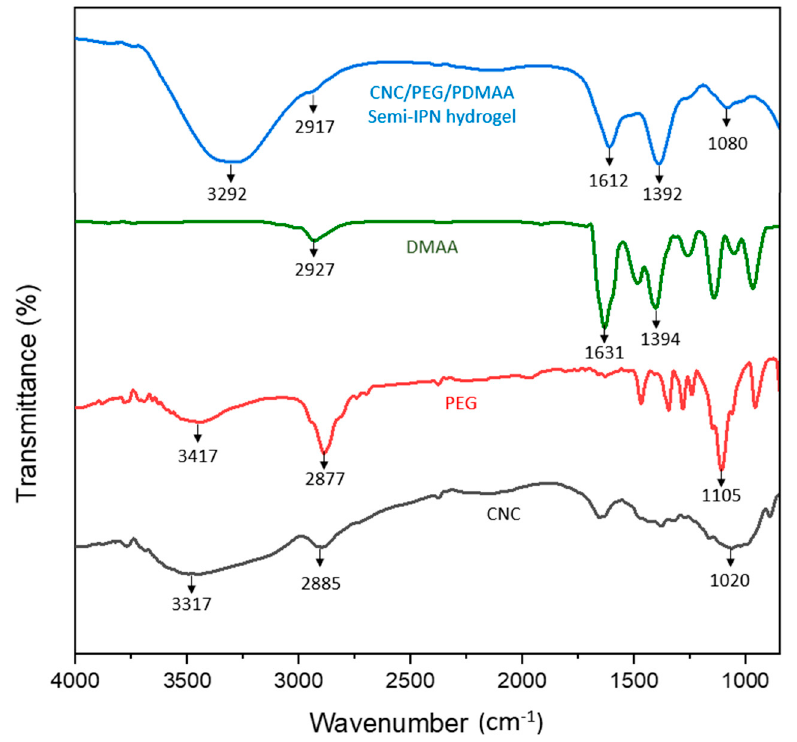
Figure 2. ATR Spectra of CNC/PEG/PDMAA semi-IPN hydrogel, DMAA, PEG, CNC. The major characteristic peaks for cellulose were at 3317 cm − 1 , due to –OH stretching, 2885 cm − 1 , which corresponded to C-H stretching in sp 3 hybridized bond, 1420 cm − 1 due to symmetric bending in –CH 2 and 1020 cm − 1 , which corresponded to C-O-C asymmetric vibration that was associated with cellulose. The major characteristic peaks for PEG were at 3417 cm − 1 due to –OH stretching, 2877 cm − 1 for stretching vibration of the –CH group, 1465 cm − 1 , which corresponded to the deformation vibration of the C-H group, 1385 cm − 1 due to –OH bending vibration and 1105 cm − 1 , which was due to C-O stretching. Moreover, the major characteristic peaks for DMAA were at 2927 cm − 1 due to C-H stretching in sp 3 hybridized bond, 1631 cm − 1 , which corresponded to C=O stretching vibration of